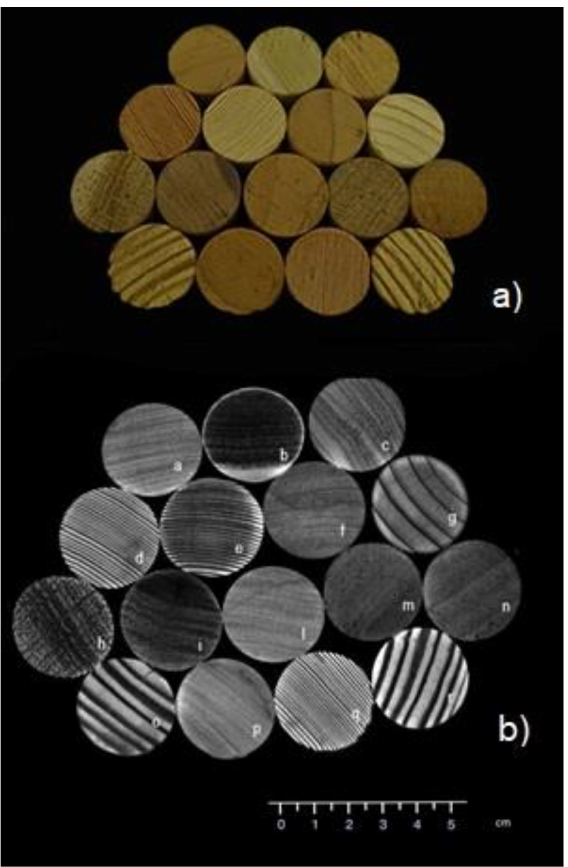
Figure 3. ( a ) Photograph image (transversal view) of the water-soaked wood sample before MRI scanning; ( b ) T 2 -w NMR image of the sample, obtained with a spin-echo-based acquisition sequence with TE = 21 ms, TR = 1500 ms, NS = 1. The overlapped letters indicate the different wooden species (see Table